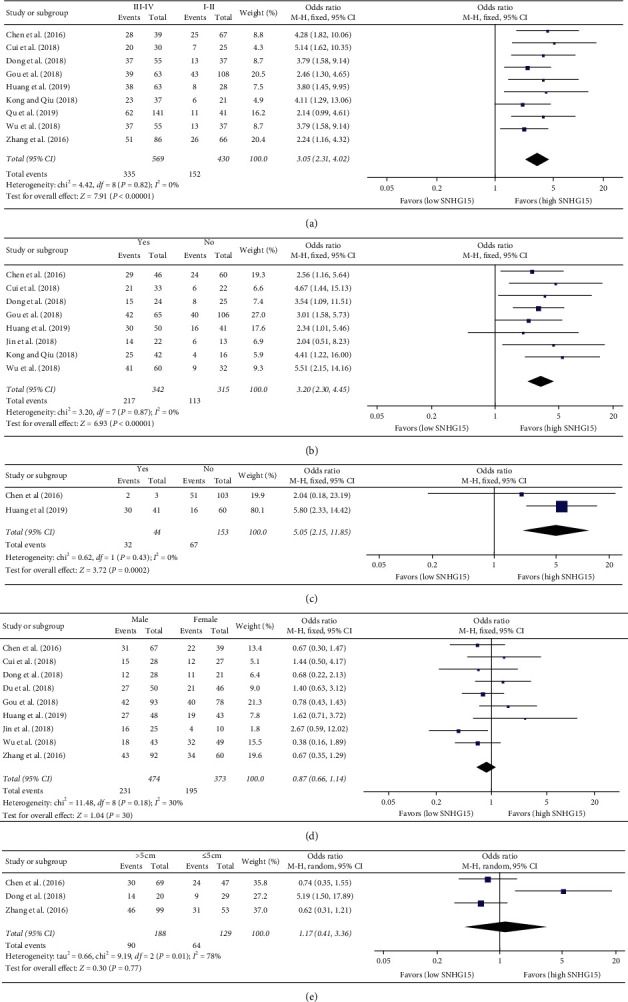
Forest plots for the association between SNHG15 expression and (a) TNM stage (III-IV vs. I-II), (b) lymph node metastasis (yes vs. no), (c) distant metastasis (yes vs. no), (d) gender (male vs. female), and (e) tumor size (>5 cm vs. ≤5 cm).